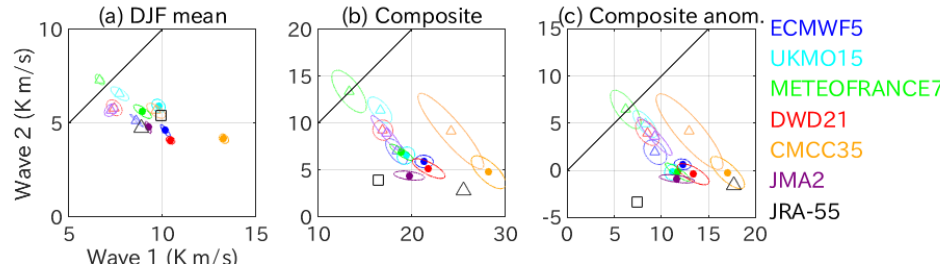
Figure 9. Similar to Figure 3, but separately using the LA MSSWs and EL MSSWs: ( a ) DJF climatology, ( b ) MSSW composite heat flux, and ( c ) MSSW composite heat flux anomalies. Thin colors and triangles are used for the MSSWs for LA. Magnitude of each ellipse is based on the 25% distance of the ensemble members.